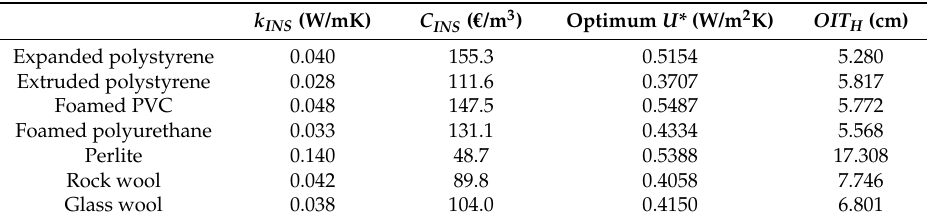
Table 11. Evaluation of various alternative insulation